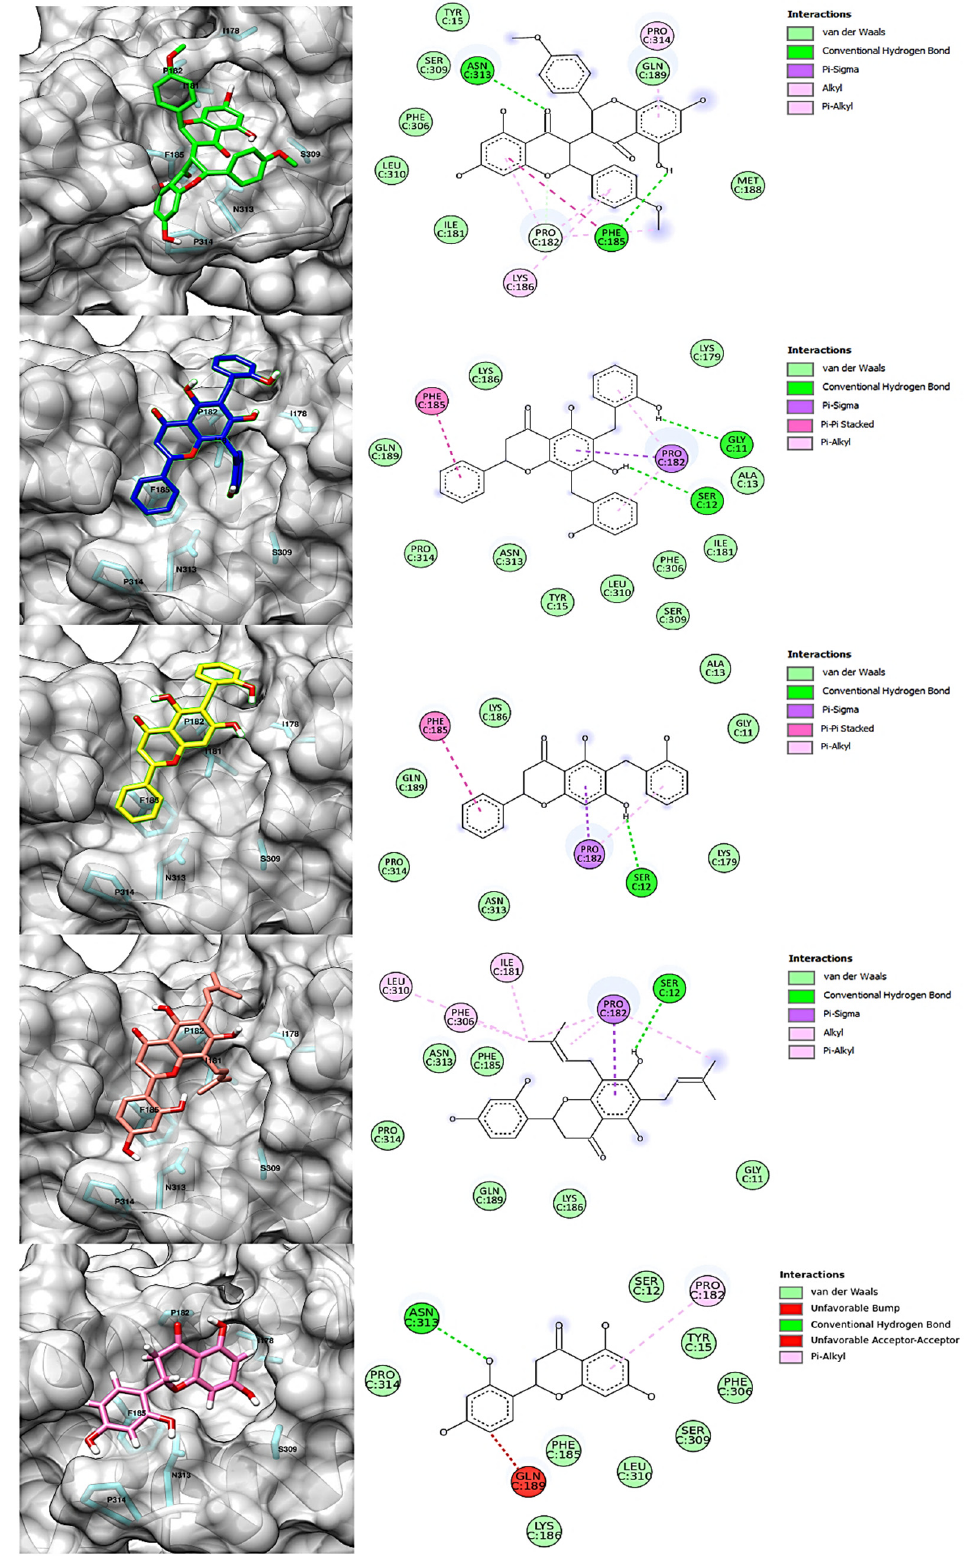
Figure 7. Intermolecular interactions formed with specific residues from the allosteric site of IDO1: chamaejasmin B, dichamanetin, isochamanetin, Kushenol E, and steppogenin, respectively.